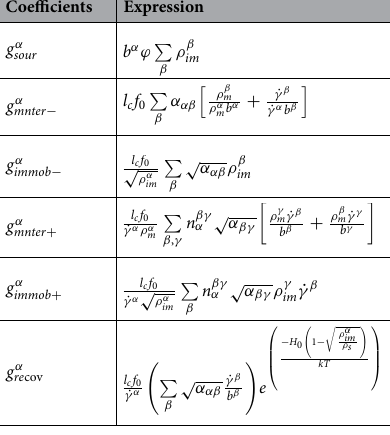
Table 1. Coefficients for dislocation-density equations (Eqs. 1–2).